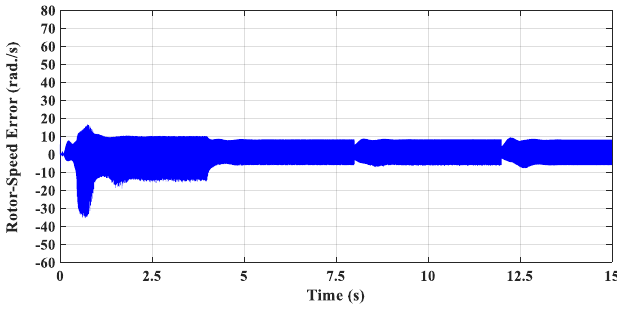
Figure 7. Speed-estimation error.